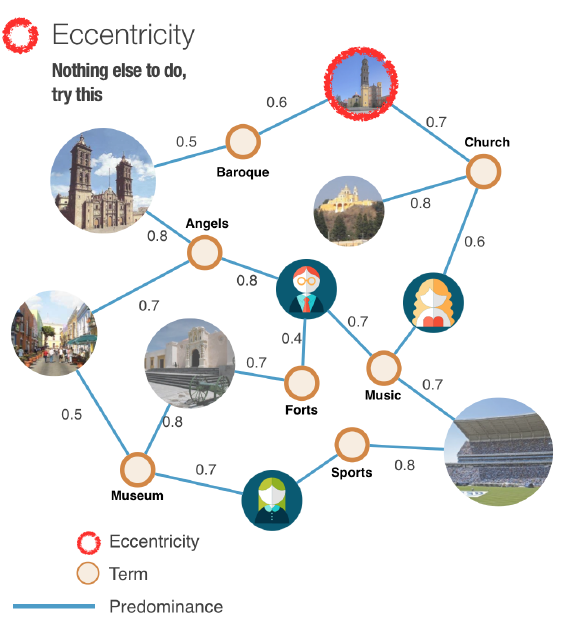
Figure 6: “Nothing else to do? Try this” as a result of computing betweenness.